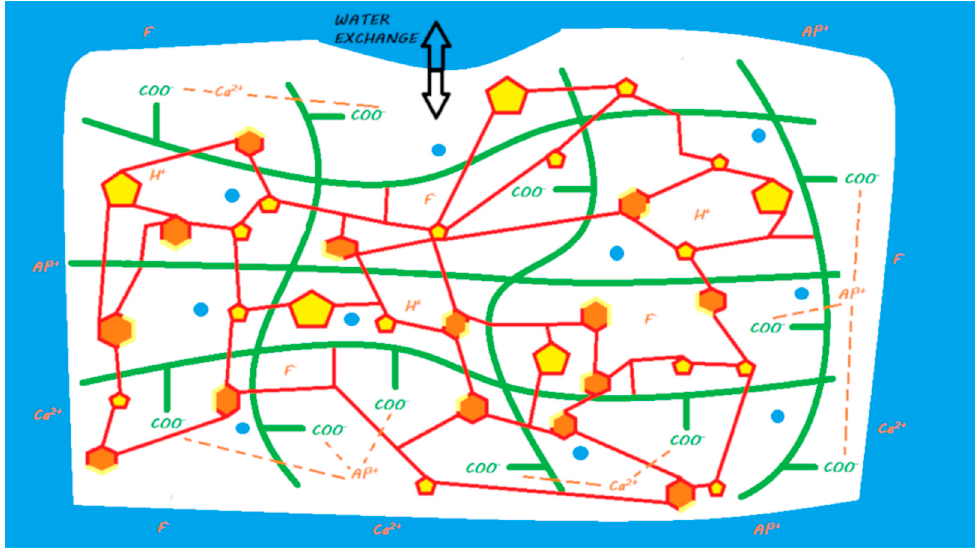
Figure 20. Ion release from Surefil One once in contact with a moist environment (i.e., oral environment). When the powder and liquid are mixed, the acid–base reaction is initiated, the setting of the material begins, and the FAS fillers are partially attacked. A silicic gel is partially formed on the FAS filler surface. The released calcium and aluminum ions are able to form ionic bonds with ionized carboxylic groups. Fluoride ions are also released. A second reaction of resin polymerization occurs during mixing, where monomers can copolymerize with silanated FAS fillers, silanated unreactive fillers, and other monomers. At the end of the reaction, two interconnected networks are obtained with covalent links between both due to the modified polyacrylic acid (MOPOS). In water, calcium, aluminum, and fluoride ions (and eventually other ions) are able to be exchanged with the oral environment.